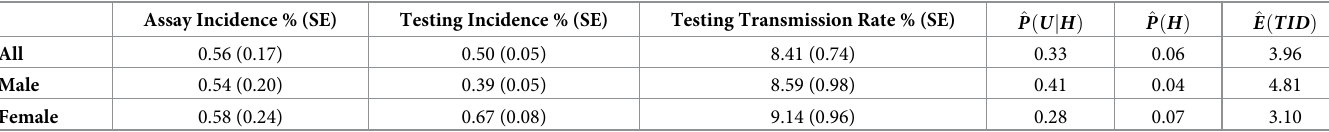
Table 3. Incidence results for KAIS 2012. Assay Incidence %